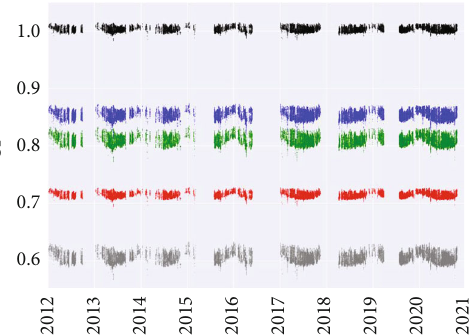
Figure 5: Spectral factor (SF) estimated at the station Bucharest for the four colored solar cells. The curve colors correspond to the cell colors except the white cell for which SF is displayed in gray. The curve in black corresponds to the silicon solar